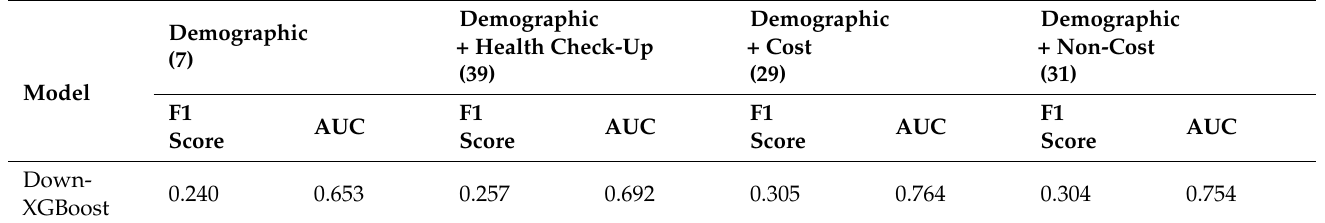
Table 6. Results of prediction model performance evaluation of variable type